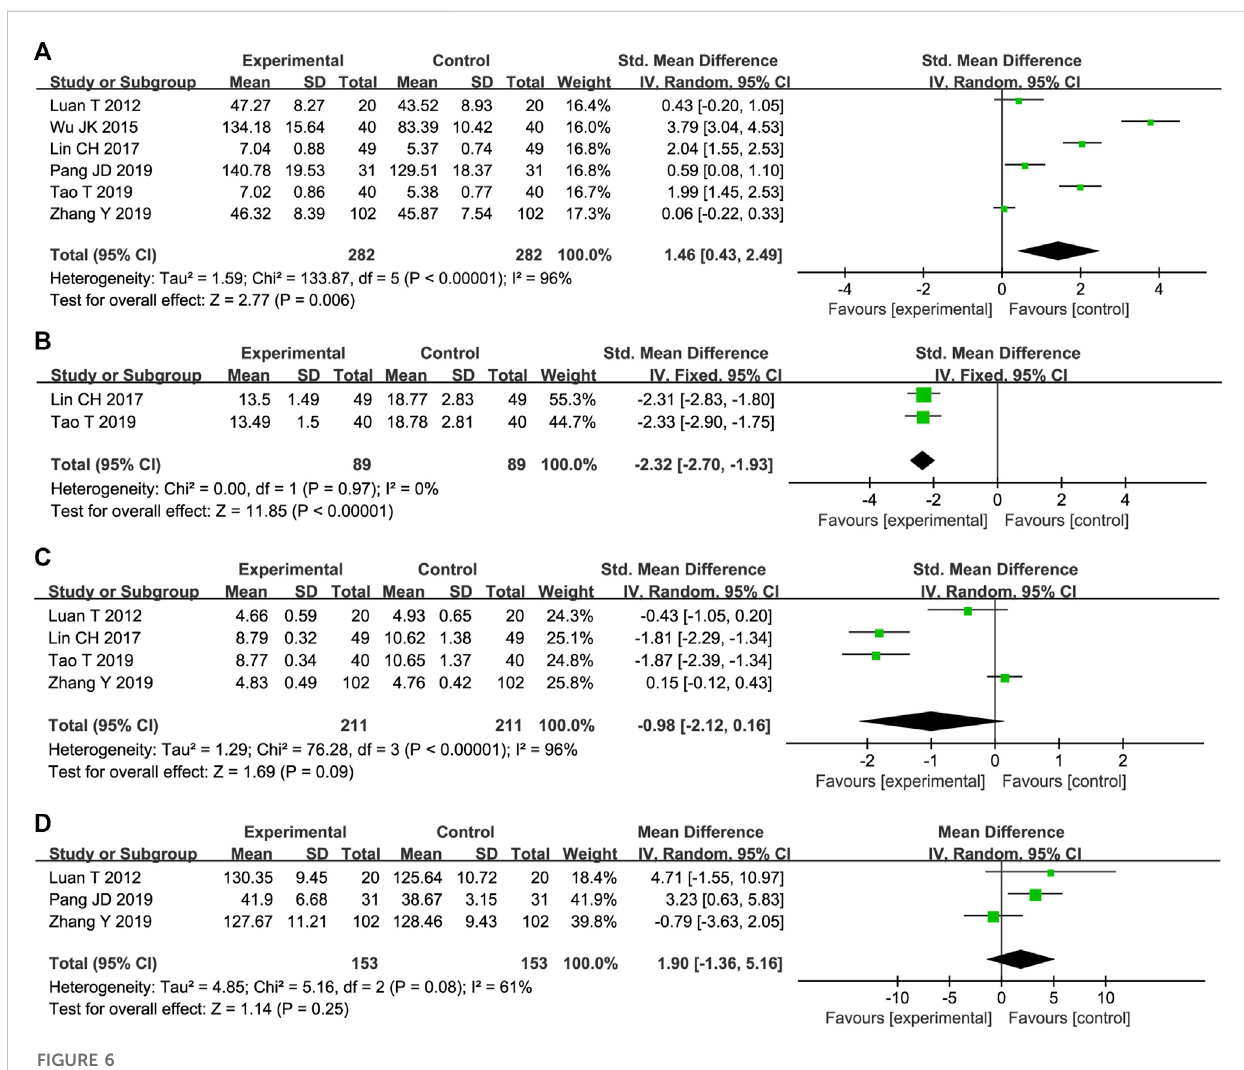
FIGURE 6 Forest plot of SOD (A) , LPO (B) , MDA (C) and NO (D)